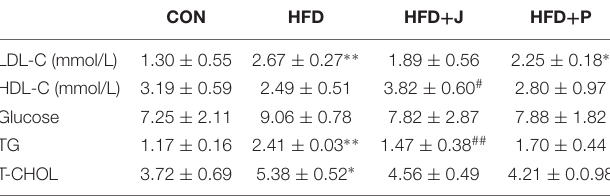
TABLE 1 | Effect of Lactobacillus jensenii IgA-21 and Pediococcus acidilactici FS-1 on serum lipid profile and glucose in HFD feeding